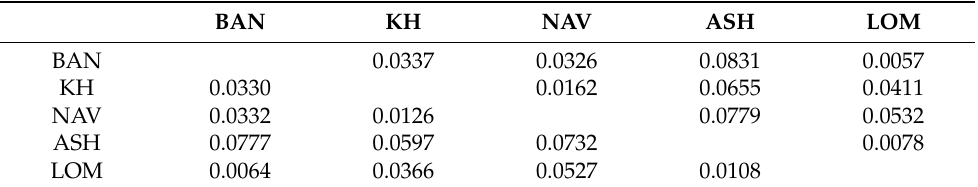
Table 3. Matrix of the genetic distance between populations. For abbreviations of the populations, see Table 1.